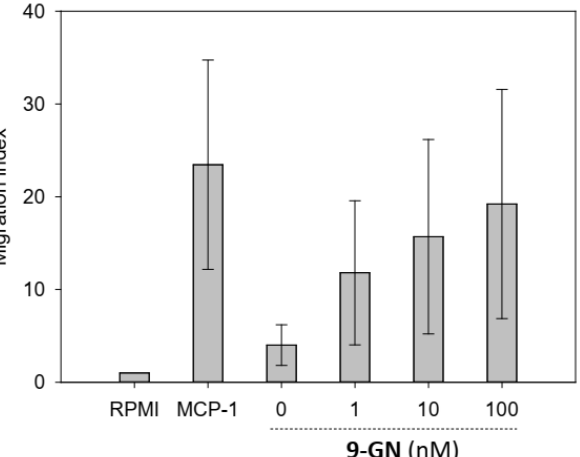
Figure 10. Monocyte migration assay in Boyden micro chambers. The data are expressed relative to the cell migration observed in the Roswell Park Memorial Institute medium (RPMI 1640) sup- plemented with 0.1% fetal calf serum. Monocyte chemotactic protein-1 (MCP-1, also called CCL2, 23 nM) was used as a positive control. The data for 0 nM of 9-GN were obtained using the protein dialysis buffer (PBS containing 10% by vol of glycerol). The bars correspond to the mean for six donors, from whom monocytes were isolated. The error bar correspond to the standard error of the mean. The data for each donor can be found in the Supplementary